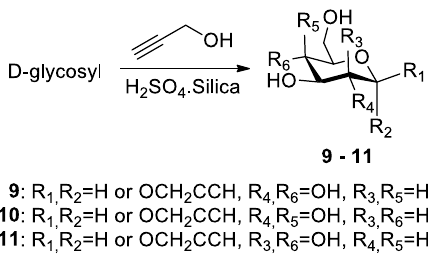
Scheme 4. Propargylation reaction of D-glucose, D-galactose, and D-mannose using sulfuric acid immobilized on silica, affording the alkynes 9 , 10 , and 11 , respectively.